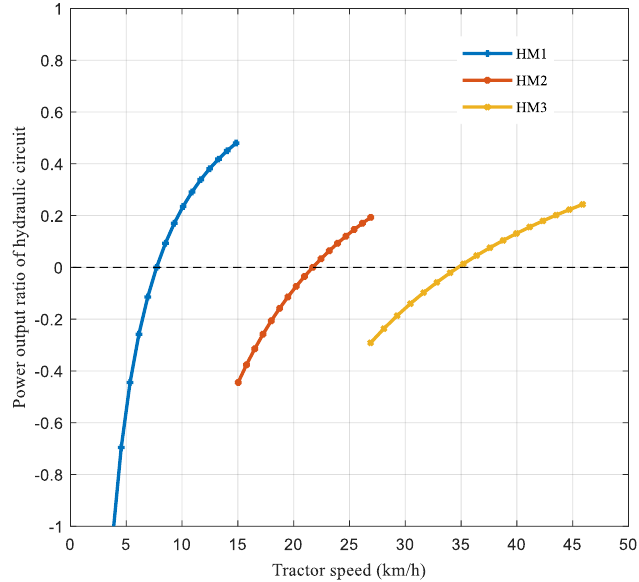
Figure 11. Relationship between power output ratio of the hydraulic circuit and vehicle speed.